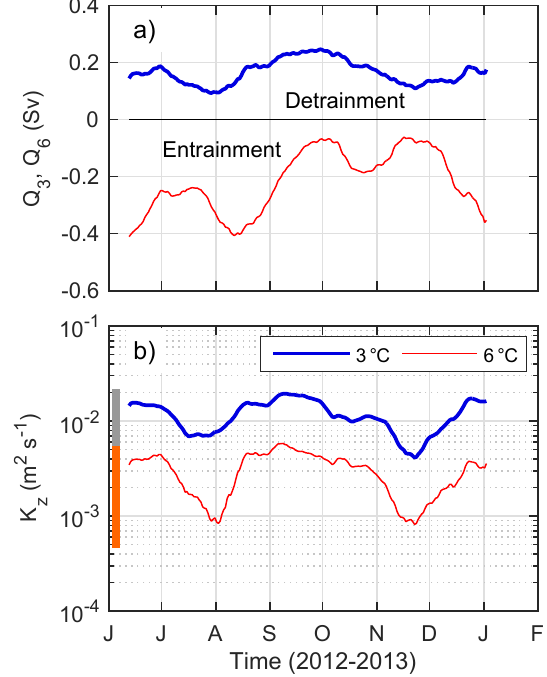
Figure 16. Time series of (a) detrainment and (b) vertical diffusiv- ity inferred from monthly heat budgets in daily moving windows. In (a) positive values indicate detrainment. Budgets are obtained be- tween arrays C and S and between the bottom and the 3 ◦ C isotherm (blue) and between the 3 and 6 ◦ C isotherms (red); cf. Fig. 15. Ver- tical bars in (b) are the ranges of vertical diffusivity in the corre- sponding layers observed in June 2010 and 2012 using microstruc- ture profilers (Fer et al., 2010,